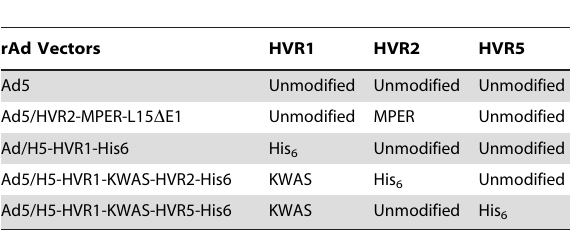
Table 1. Description of vectors used in the